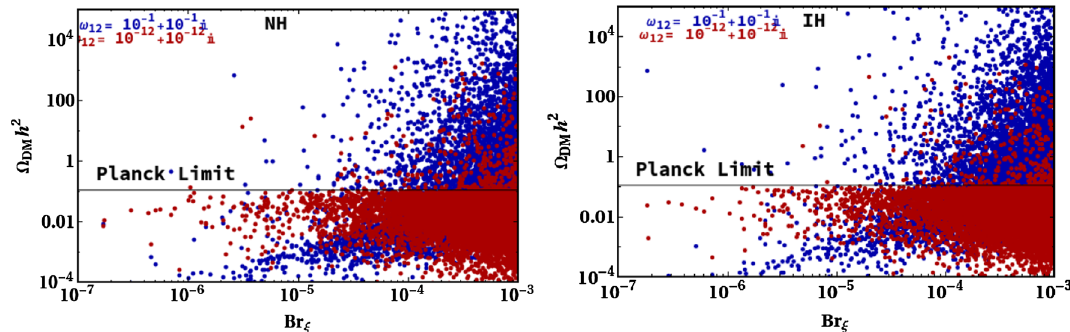
Fig. 9 The plot shows variation of relic abundance w.r.t the branching ratio of the decay N 1 −→ ξχ for two different values of arbitrary angle ω